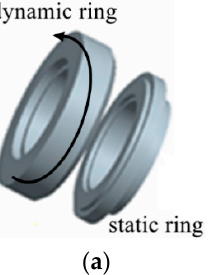
Table 1. Leakage rates calculated in different locations.